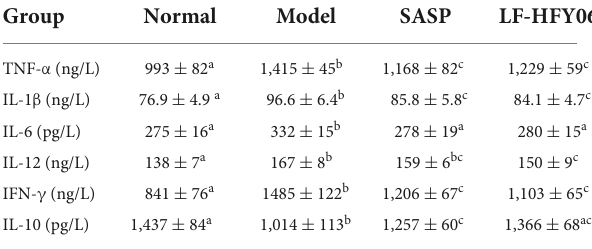
TABLE 5 Serum levels of TNF- α . Group Normal Model SASP